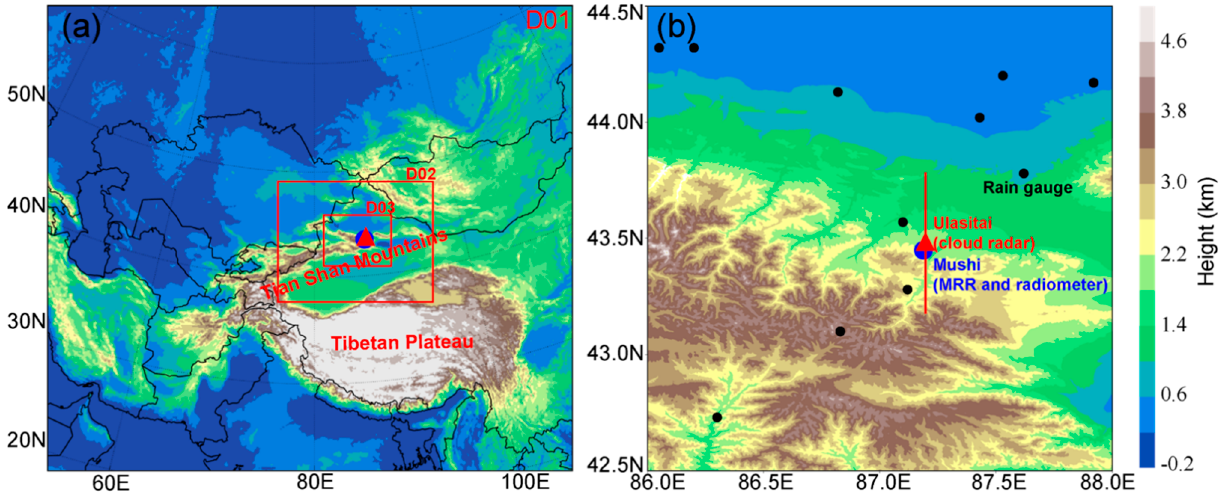
Figure 1. ( a ) Domains of the WRF model simulation and topography. D01, D02, and D03 indicate the three nested domains used in the simulation; ( b ) Topography of the middle of the Tian Shan area. The red triangle indicates the location of Ka-band radar, the red vertical line in ( b ) indicates the range of the range − height indicator (RHI) scan, the blue dot indicates the location of an MRR, and the black dots in ( b ) indicate the locations of rain gauges.